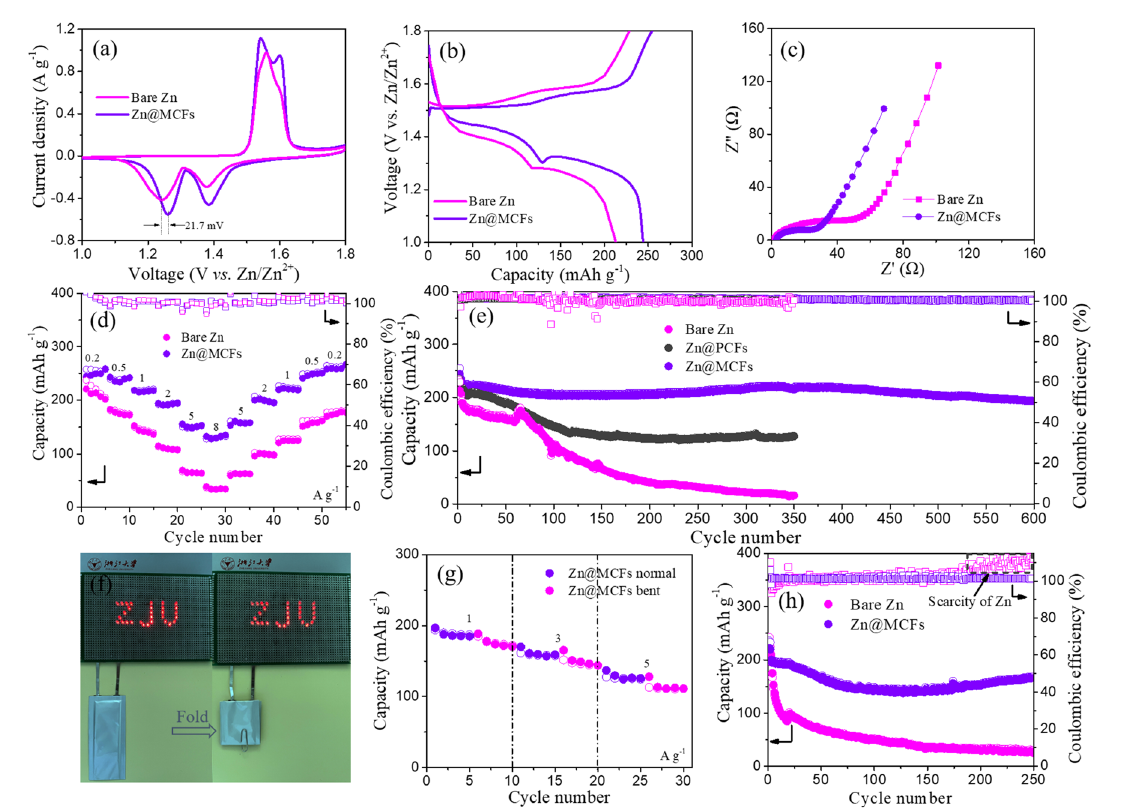
Fig. 5 Electrochemical performance of aqueous Zn||α‑MnO 2 batteries. a CV curves of bare Zn||α‑MnO 2 and Zn@MCFs||α‑MnO 2 at 0.1 mV s −1 . b Voltage–capacity curves at 0.2 A g −1 . c EIS spectra before cycling. d Rate performance ranging from 0.2 to 8 A g −1 . e Long‑span cycling per‑ formance of Zn||MnO 2 batteries using various anodes (activating at 0.2 A g −1 for two cycles and cycling at 1 A g −1 ). f Optical photographs of 30 red LEDs lit by Zn@MCFs||α‑MnO 2 pouch batteries under normal and bent (180°) states. g Rate performance of Zn@MCFs||α‑MnO 2 pouch batteries under normal and bent states. h Cycling performance of Zn||α‑MnO 2 and Zn@MCFs||α‑MnO 2 pouch batteries at 1 A g −1 after activa‑ tion at 0.2 A g −1 for two